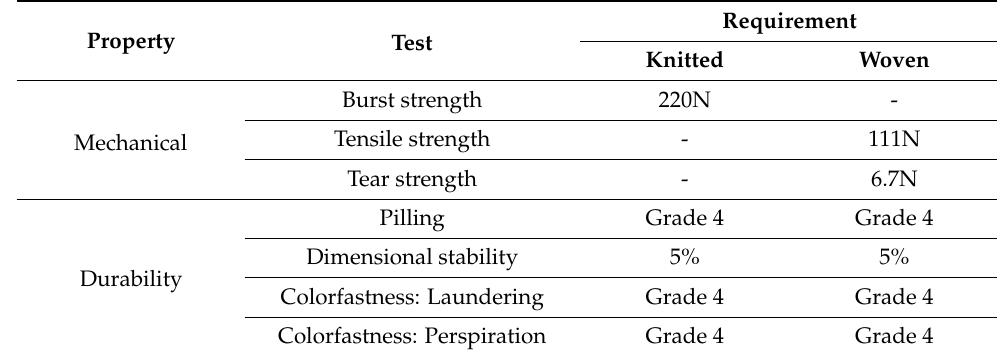
Table 3. Mechanical and durability requirements according to ASTM D7019